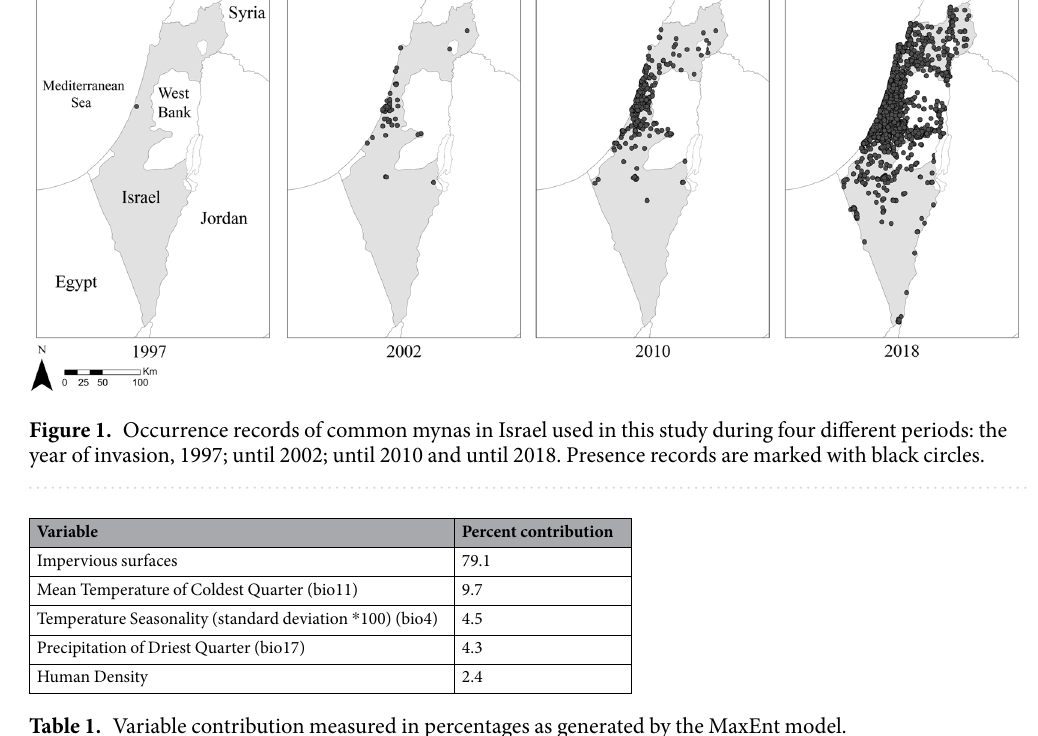
Table 1. Variable contribution measured in percentages as generated by the MaxEnt